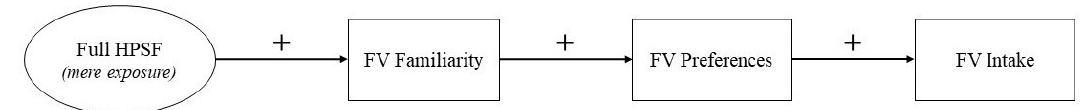
Figure 1. Hypothesized working mechanism of the full HPSF intervention. + Indicates a positive relationship between the